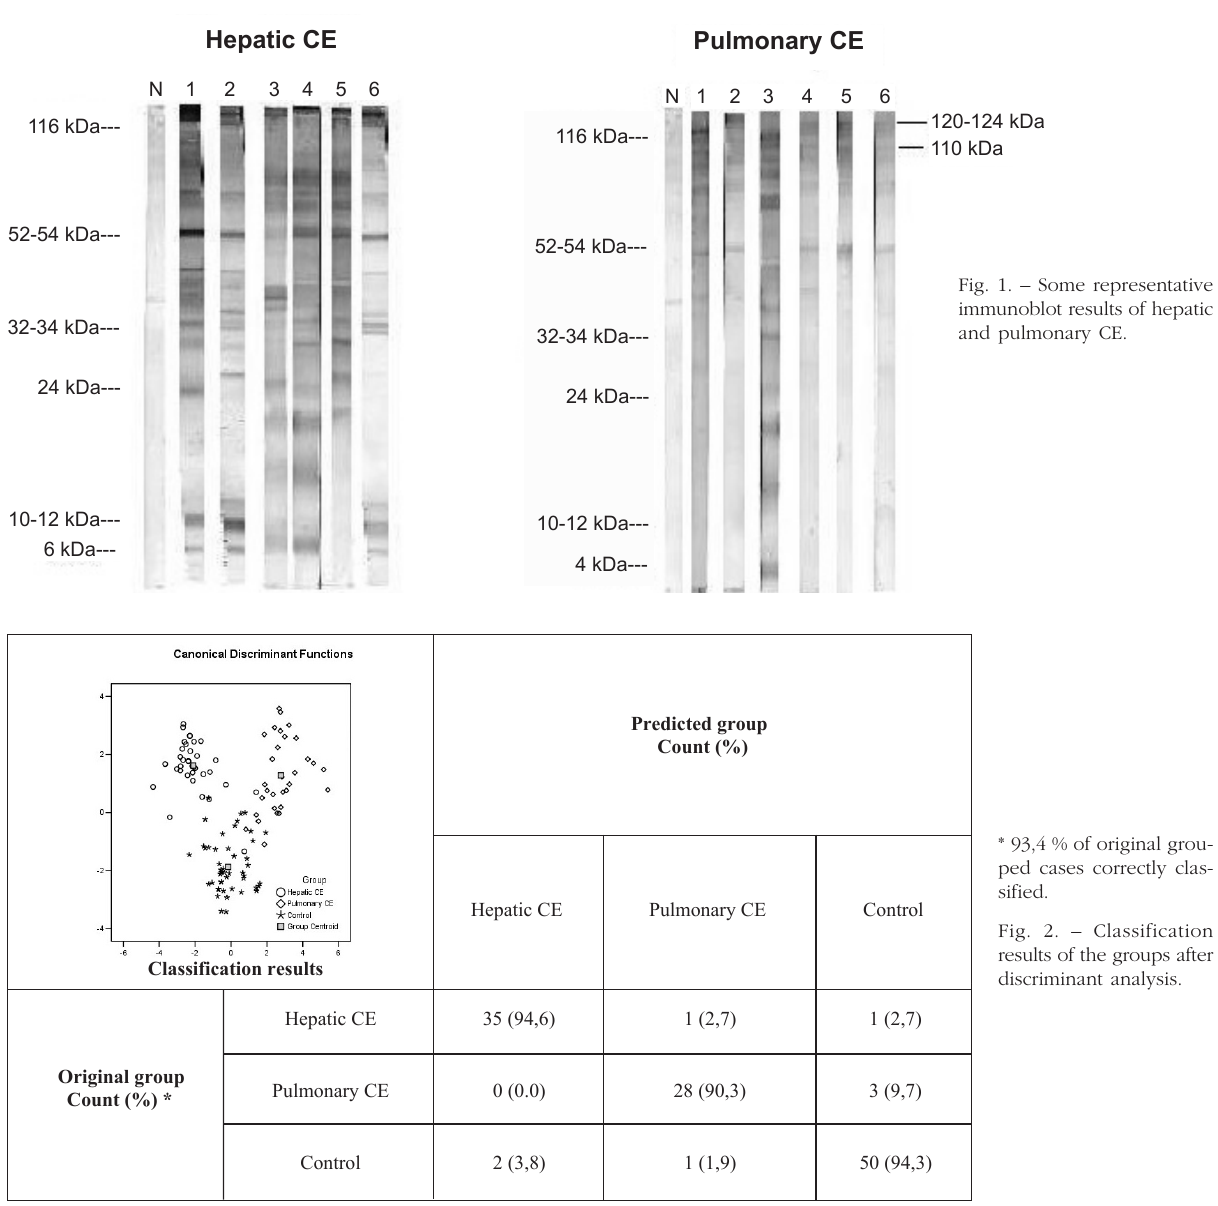
Fig. 2. – Classification results of the groups after discriminant